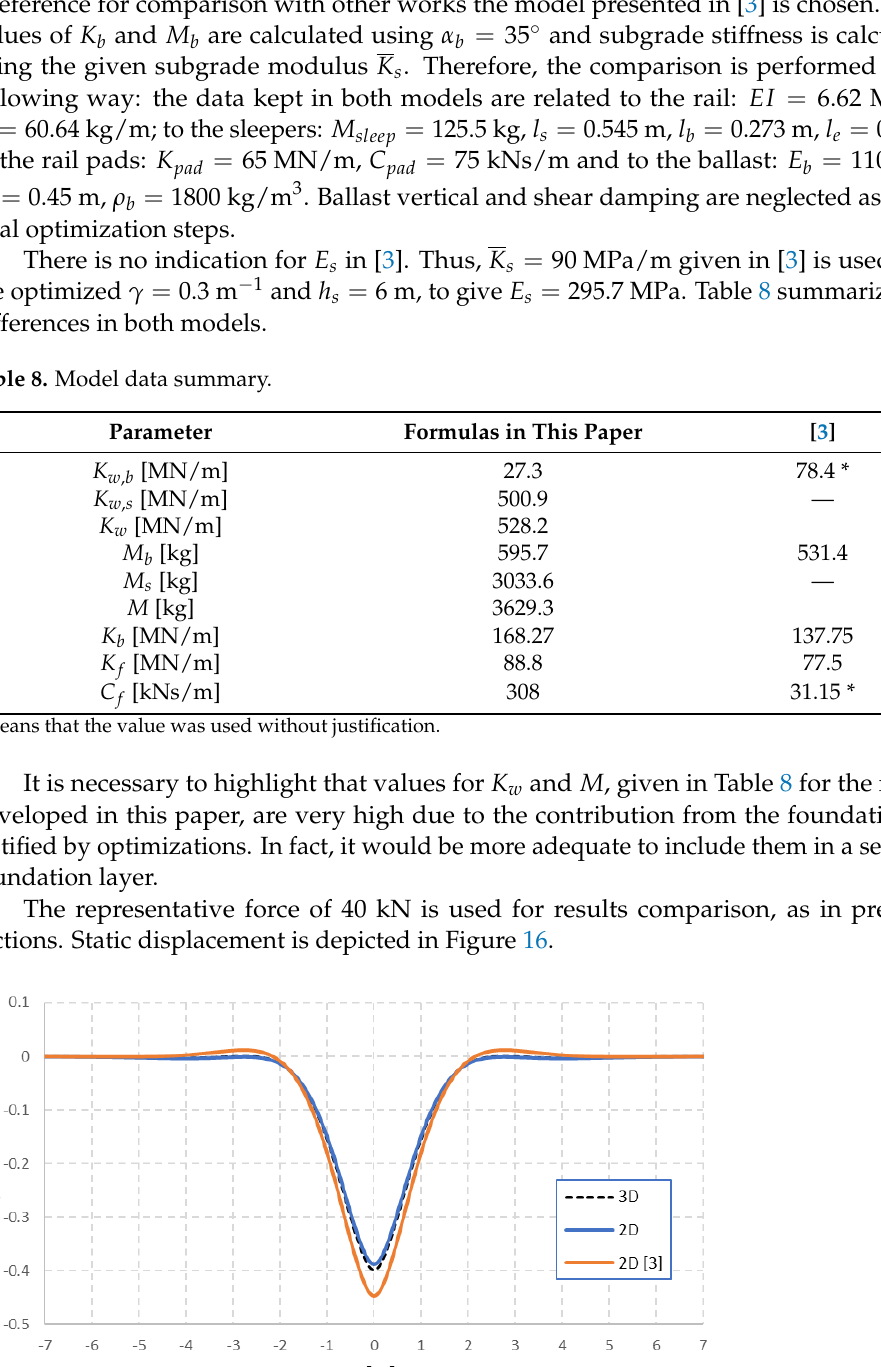
Table 8. Model data summary.